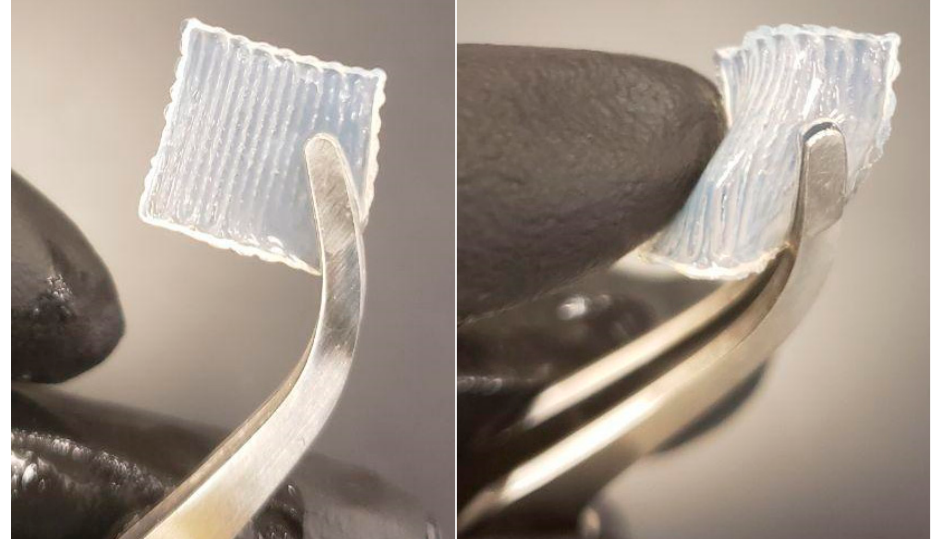
Figure 2. The configuration and flexibility of the 3D-printed membrane allow for its easy surgical handling as confirmed by the surgeon during the in vivo study.